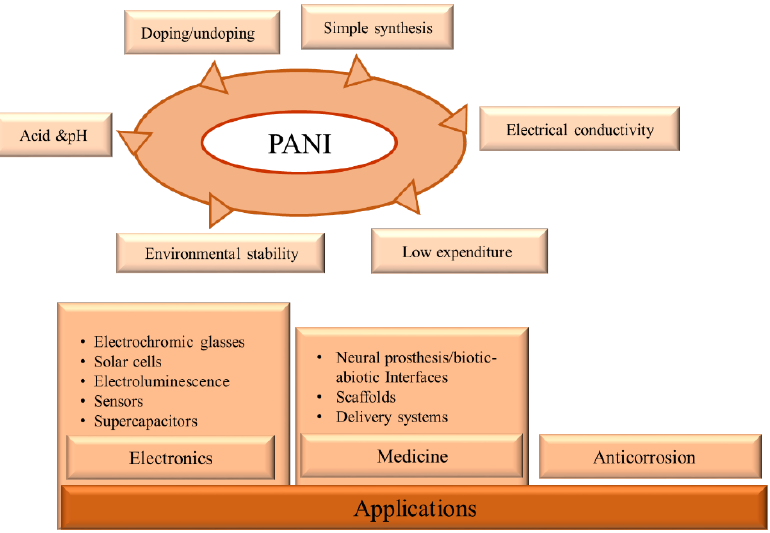
Figure 3. Prominent properties and usage of polyaniline.